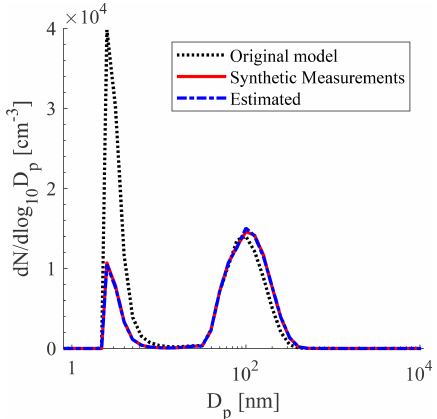
Figure 5. Average particle size distributions in scenario no. 14 (nucleation, SOA production, POA emission rates: 2.7cm − 3 s − 1 , 15µgm − 3 d − 1 , 872cm − 3 h − 1 ) from synthetic measurements, TOMAS run with a priori rates, and estimated with the inverse model are shown in the solid red, dotted black, and dashed blue profiles,